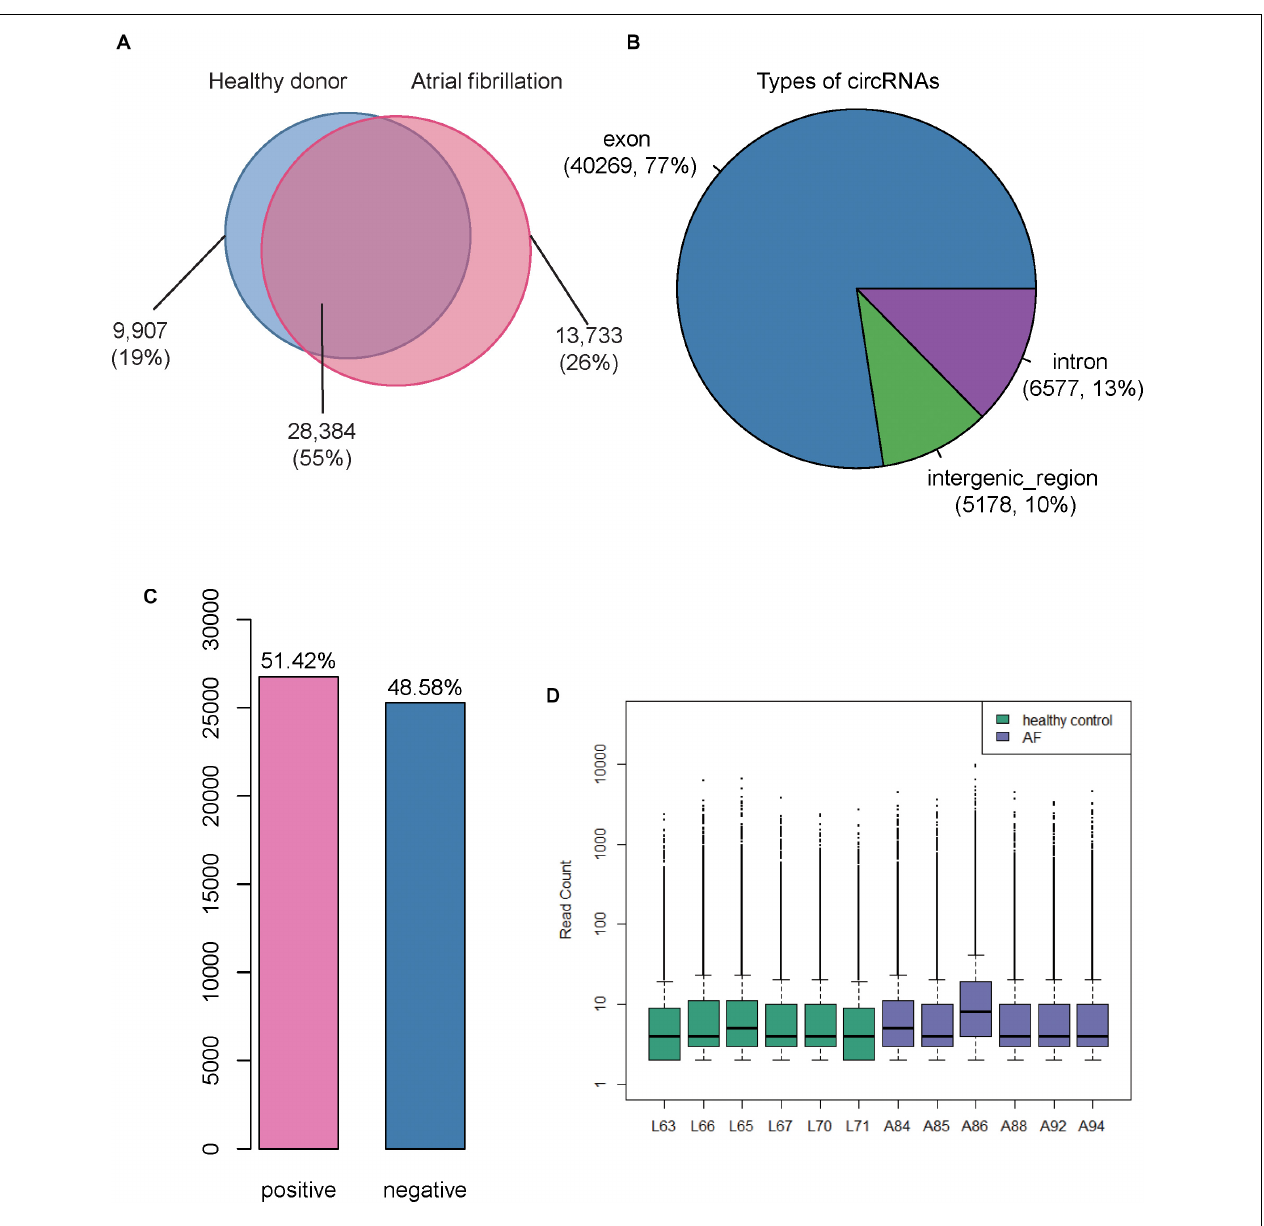
FIGURE 1 | Overview of the identified Circular RNAs (circRNAs) in atrial fibrillation (AF) and healthy controls. (A) The Venn diagram displays the number of circRNAs identified in AF and healthy controls, respectively. (B) The pie chart displays the ratio and number of circRNAs originated from exonic, intronic, and intergenic regions. (C) The number and ratio of circRNAs transcribed from sense and antisense strands. (D) The distribution of count-based circRNA expression in each sample. The purple and green boxes represent the AF and healthy control samples,